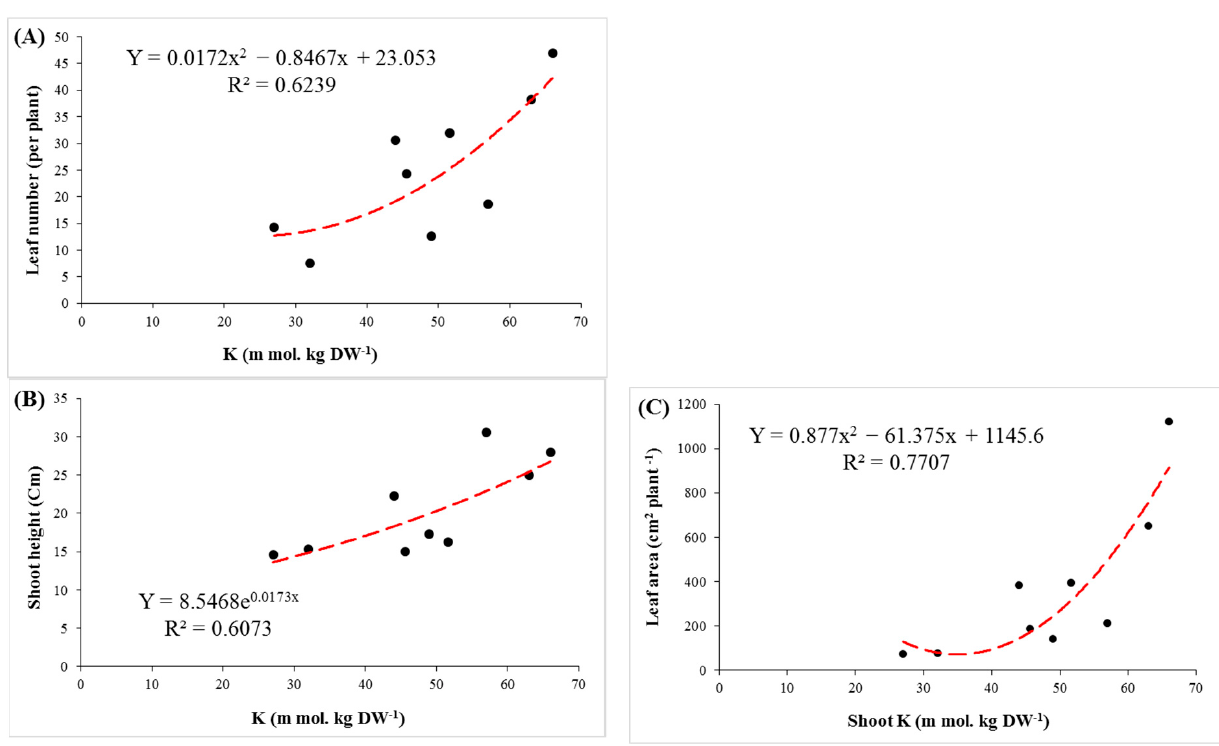
Figure 5. The regression of K + concentration in shoots with leaf number ( A ), shoot height ( B ) and leaf area ( C ) in three pistachio rootstocks after 90 days of salinity stress.